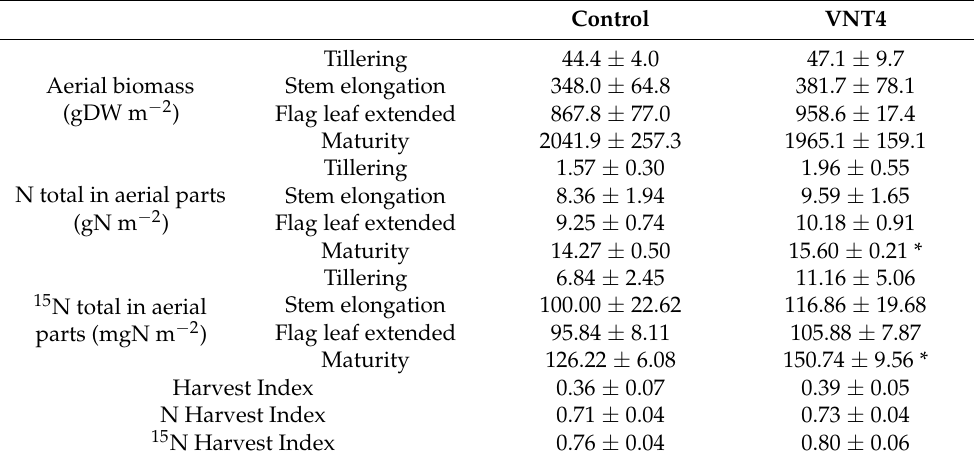
Table 3. Agronomic and N-related traits at maturity at site 4 in 2020 (Experiment 2 with 15